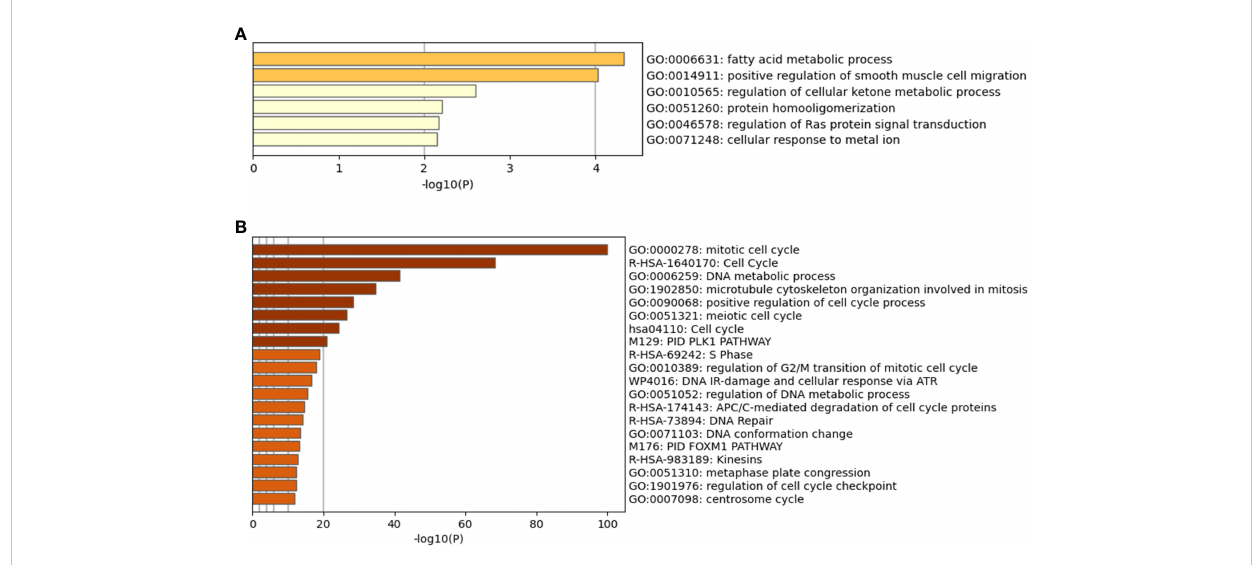
FIGURE 4 Metascape analysis for differentially expressed genes. (A) is the High Survivors group, whilst (B) is the Low Survivors